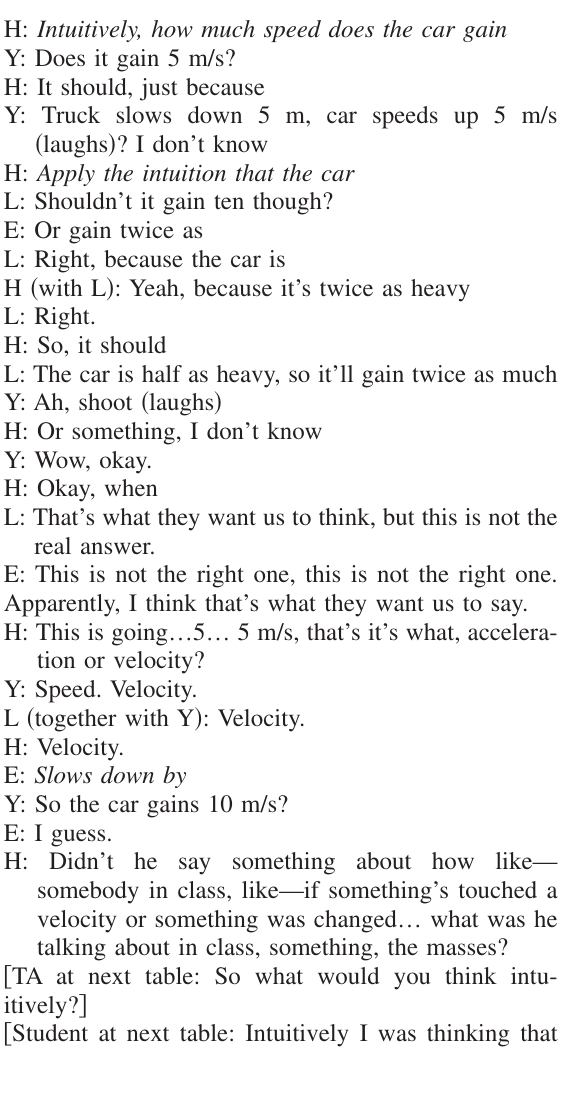
FIG. 1. Excerpt of tutorial on Newton’s third